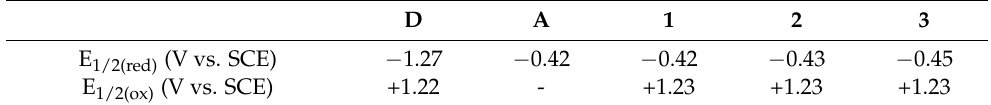
Table 2. Redox data of the studied